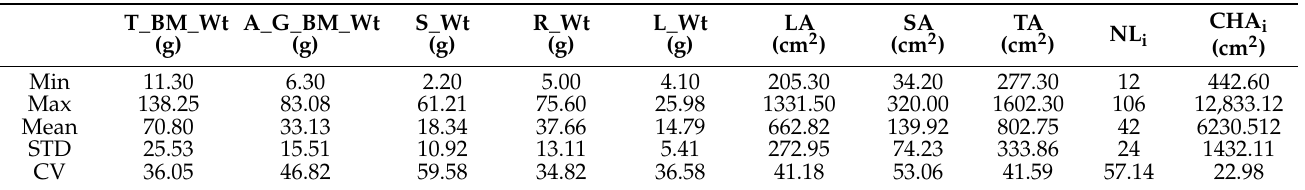
Table 2. Descriptive statistics of the quantitative traits and image traits of different genotypes